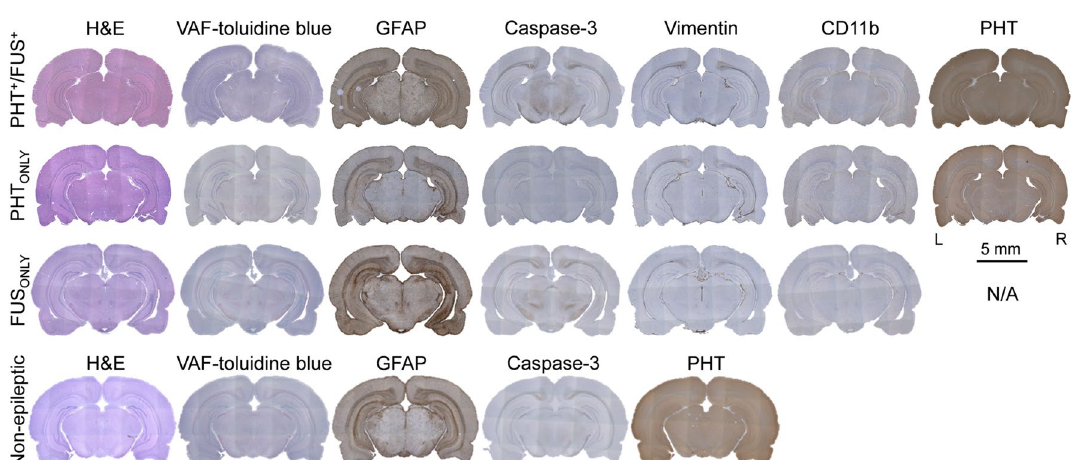
Figure 8. Representative histology and IHC results. These slides were obtained from mTLE rats of PHT + /FUS + (top), PHT ONLY (2nd row) and FUS ONLY (3rd row) groups as well as a non-epileptic rat (bottom) that underwent the same PHT + /FUS + treatments. IHC slides of PHT for FUS ONLY condition and vimentin and CD11b for non- epileptic rats are not shown as they are not applicable (N/A). In the PHT + /FUS + condition, the three white dots on the left side of GFAP IHC were staining artifacts. L left, R